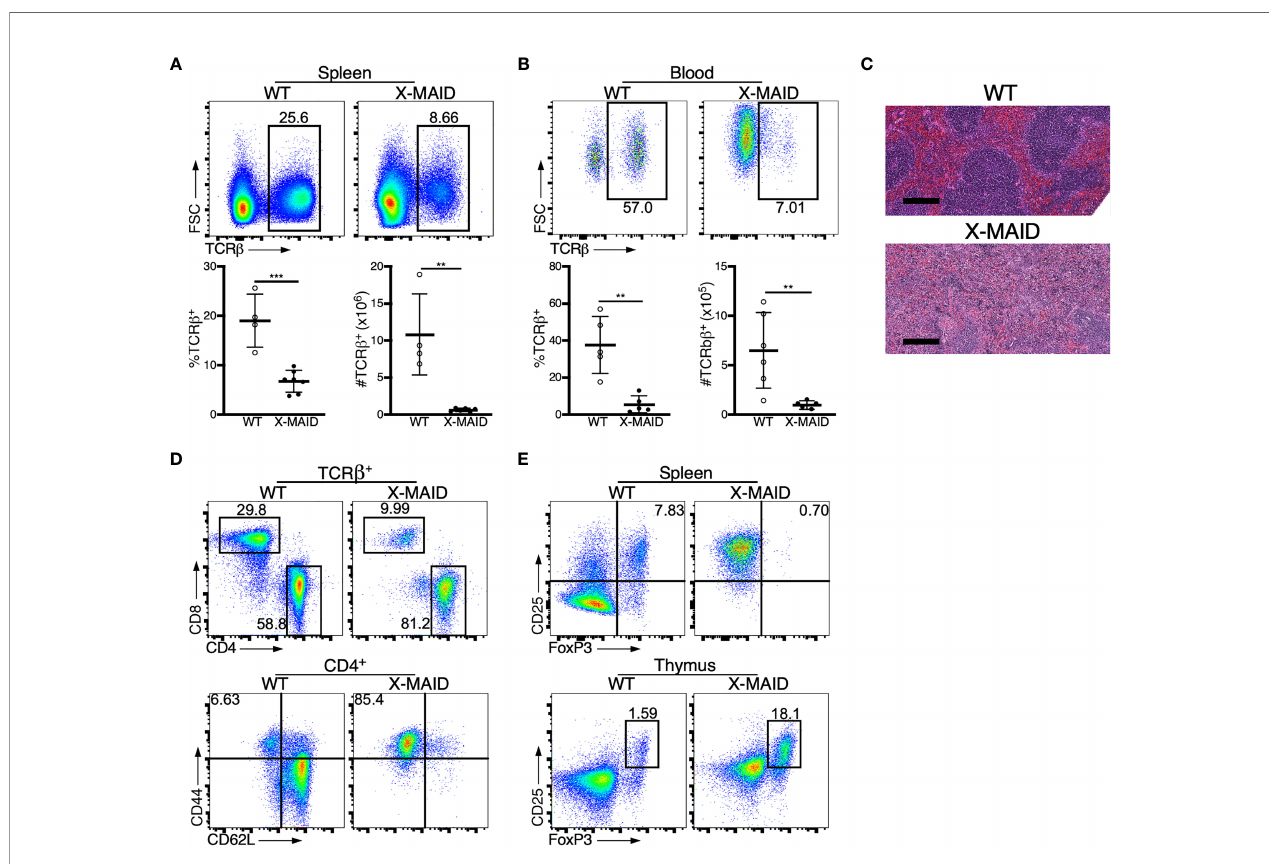
FIGURE 2 | Dysregulation of T cell populations in peripheral lymphoid organs of X-MAID mice. WT or X-MAID male mice were sacri fi ced at 3-5 weeks old, and the indicated tissues were harvested for analysis. (A, B) Using fl ow cytometry, gated on live single cells, the proportion and absolute number of TCR b + cells were determined from (A) spleen or (B) blood. (C) H&E staining from spleen sections shows a loss of follicle structure. Scale bars = 200 m m. (D) Representative fl ow plots of CD4 + and CD8 + T cell subsets gated on TCR b + live single cells from the spleens of WT or X-MAID mice (top). Further analysis of CD44 and CD62L expression on CD4 + T cells reveals elevated activation status (bottom). (E) CD25 + FoxP3 + cells from the spleen (top) or thymus (bottom) of WT or X-MAID male mice gated on CD4 SP live single cells. Data in C-E are representative of results from at least 6 individual mice. Data in (A, B) represent means ± StDev, with each point representing an individual mouse. Statistics were calculated using a Student ’ s t test, **p < 0.01, ***p <